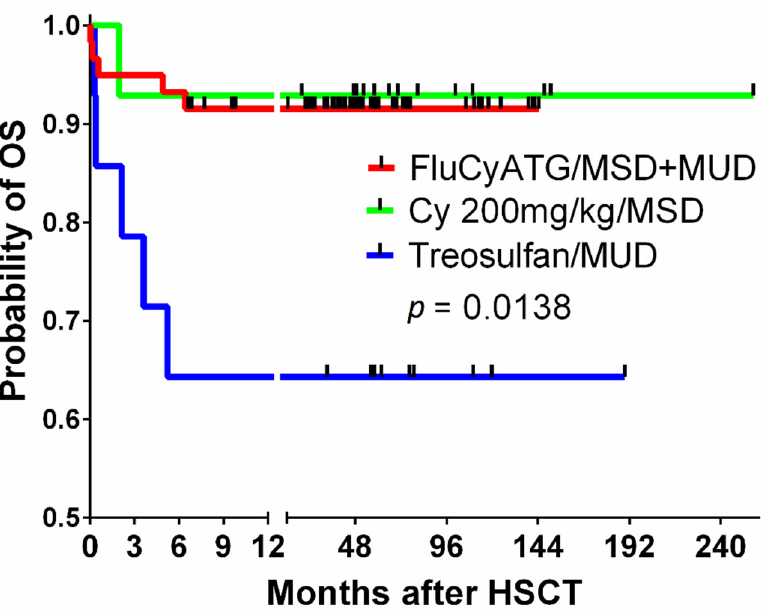
Figure 1. The overall survival of children with SAA undergoing transplantation after the fludarabine–cyclophosphamide–ATG protocol compared to that of a historic group of MSD recipients conditioned with cyclophosphamide 200 mg/kg BW and ATG and MUD recipients after treosulfan-based conditioning. Legend. SAA, severe aplastic anemia; ATG, antithymocyte globulin, MSD, matched sibling donor; BW, body weight; MUD, matched unrelated donor.